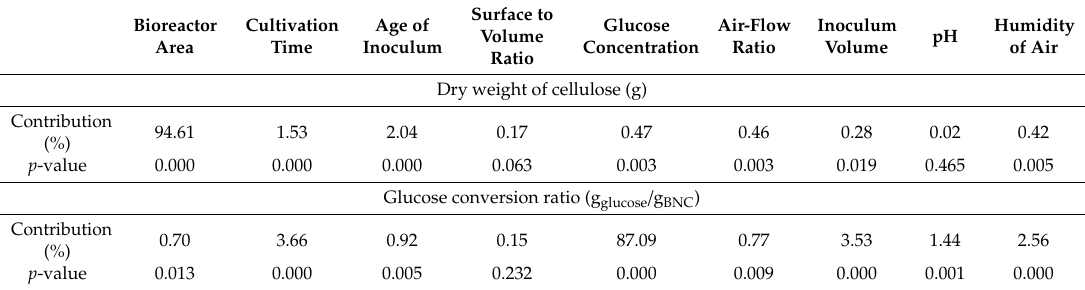
Figure 3. Main effect plots of studied parameters for dry weight of cellulose (blue lines) and glucose conversion into cellulose (green lines). Table 3. Plackett–Burman design % contribution and p -value of the